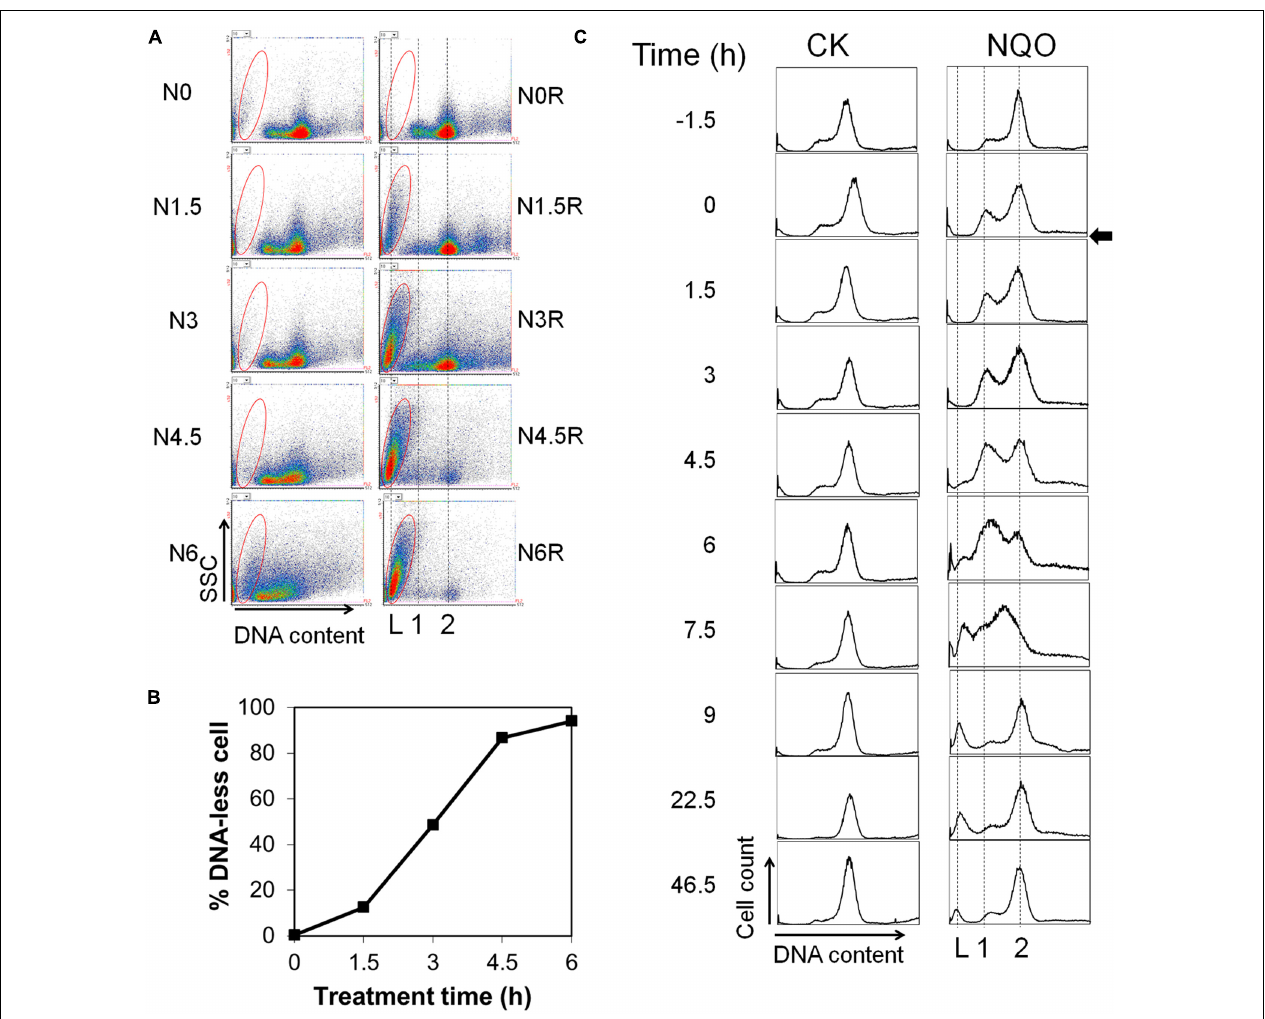
FIGURE 2 | Analysis of the effects of transient NQO treatment on Sulfolobus cells. (A) S. islandicus cells were treated with 4 µ M NQO for 0, 1.5, 3, 4.5, and 6 h respectively and analyzed by flow cytometry (N0, N1, N1.5, N3, N4.5, N6, left panels). Meanwhile, the cells were released and recovered in fresh medium for 24 h, when DNA content distributions were also analyzed by flow cytometry (N0R, N1R, N1.5R, N3R, N4.5R, N6R, right panels). The results were shown in FL2 (DNA content, horizontal axis)-SSC (side scattered light, vertical axis) cytograms. Both axes are shown in liner scale. (B) DNA-less cells from (A) were quantified. Very similar data were obtained from three independent experiments, and one set of representative data is shown. (C) Control and NQO-treated cells were released into fresh medium after incubation for 1.5 h (indicated as time “0” by an arrowhead). The cultures were further grown for 46.5 h, during which cell samples were taken DNA content profiles analyses. Populations of DNA-less cells (L), cells carrying one or two copies of chromosomes (1 and 2, respectively) are